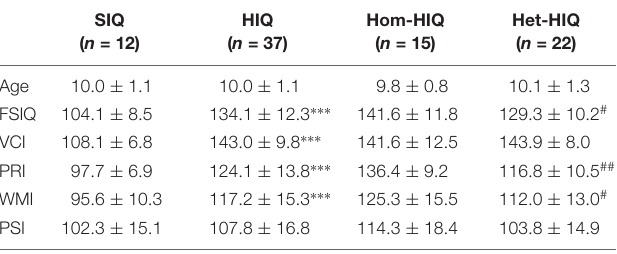
TABLE 1 | Population characteristics (mean ± SD): age, full-scale IQ (FSIQ), verbal comprehension index (VCI), perceptual reasoning index (PRI), processing speed index (PSI), and working memory index (WMI) for standard intelligence quotient (SIQ), high intelligence quotient (HIQ) groups, and HIQ subgroups: homogeneous (Hom-HIQ) and heterogeneous